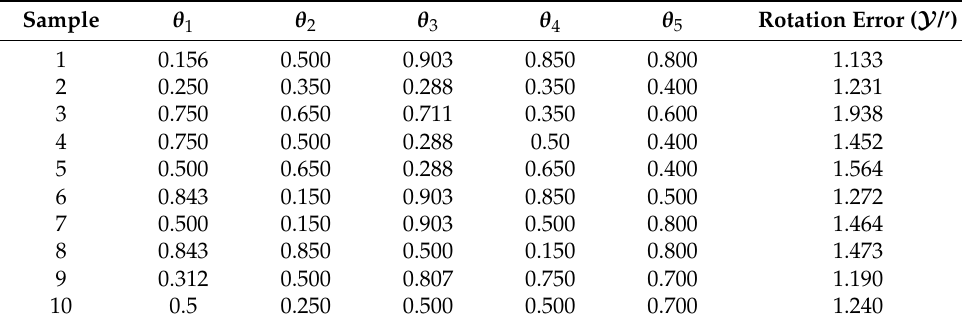
Table 4. Partially normalized sample data.